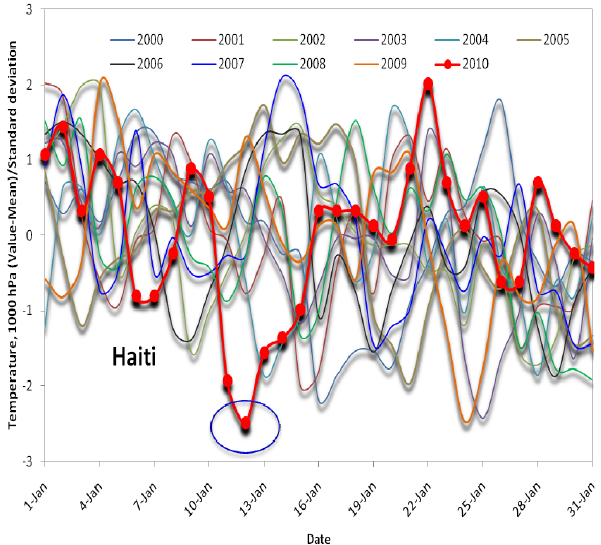
ture anomaly computed from AIRS data over the epicenter of Haiti